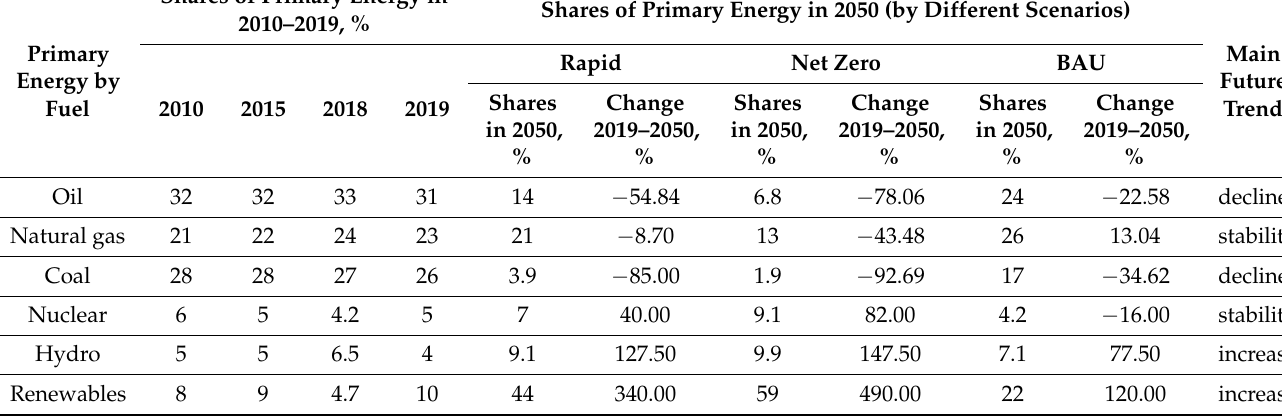
sources (Table 1) [44]. Table 1. Shares of primary energy (current and future Table 1. Shares of primary energy (current and future trends).